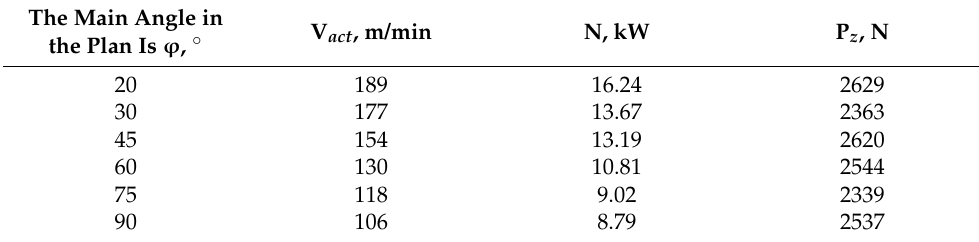
Table 5. Change in cutting force from the main angle in terms of the boring head. The Main Angle